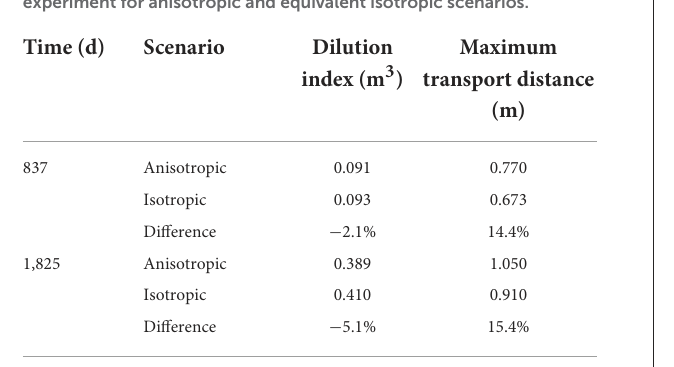
TABLE 4 Dilution index, representing simulated plume volume, and maximum transport distance for the Mont Terri CI-D in-situ diffusion experiment for anisotropic and equivalent isotropic scenarios.